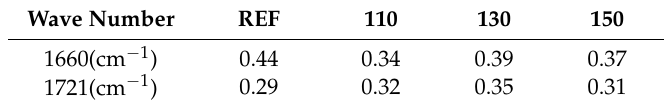
Table 3. Relative peak height (H’) of carbonyl groups in the lignin FTIR spectra. Wave Number